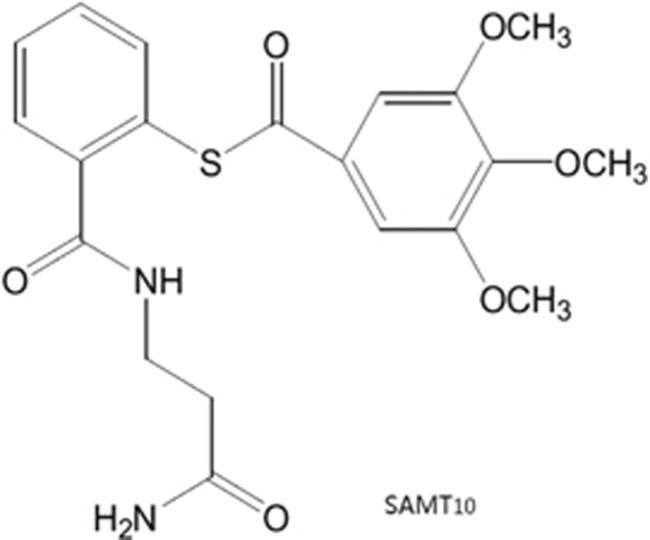
Chemical structure of SAMT10. S-acyl-2-mercaptobenzamide thioester-10, SAMT10.